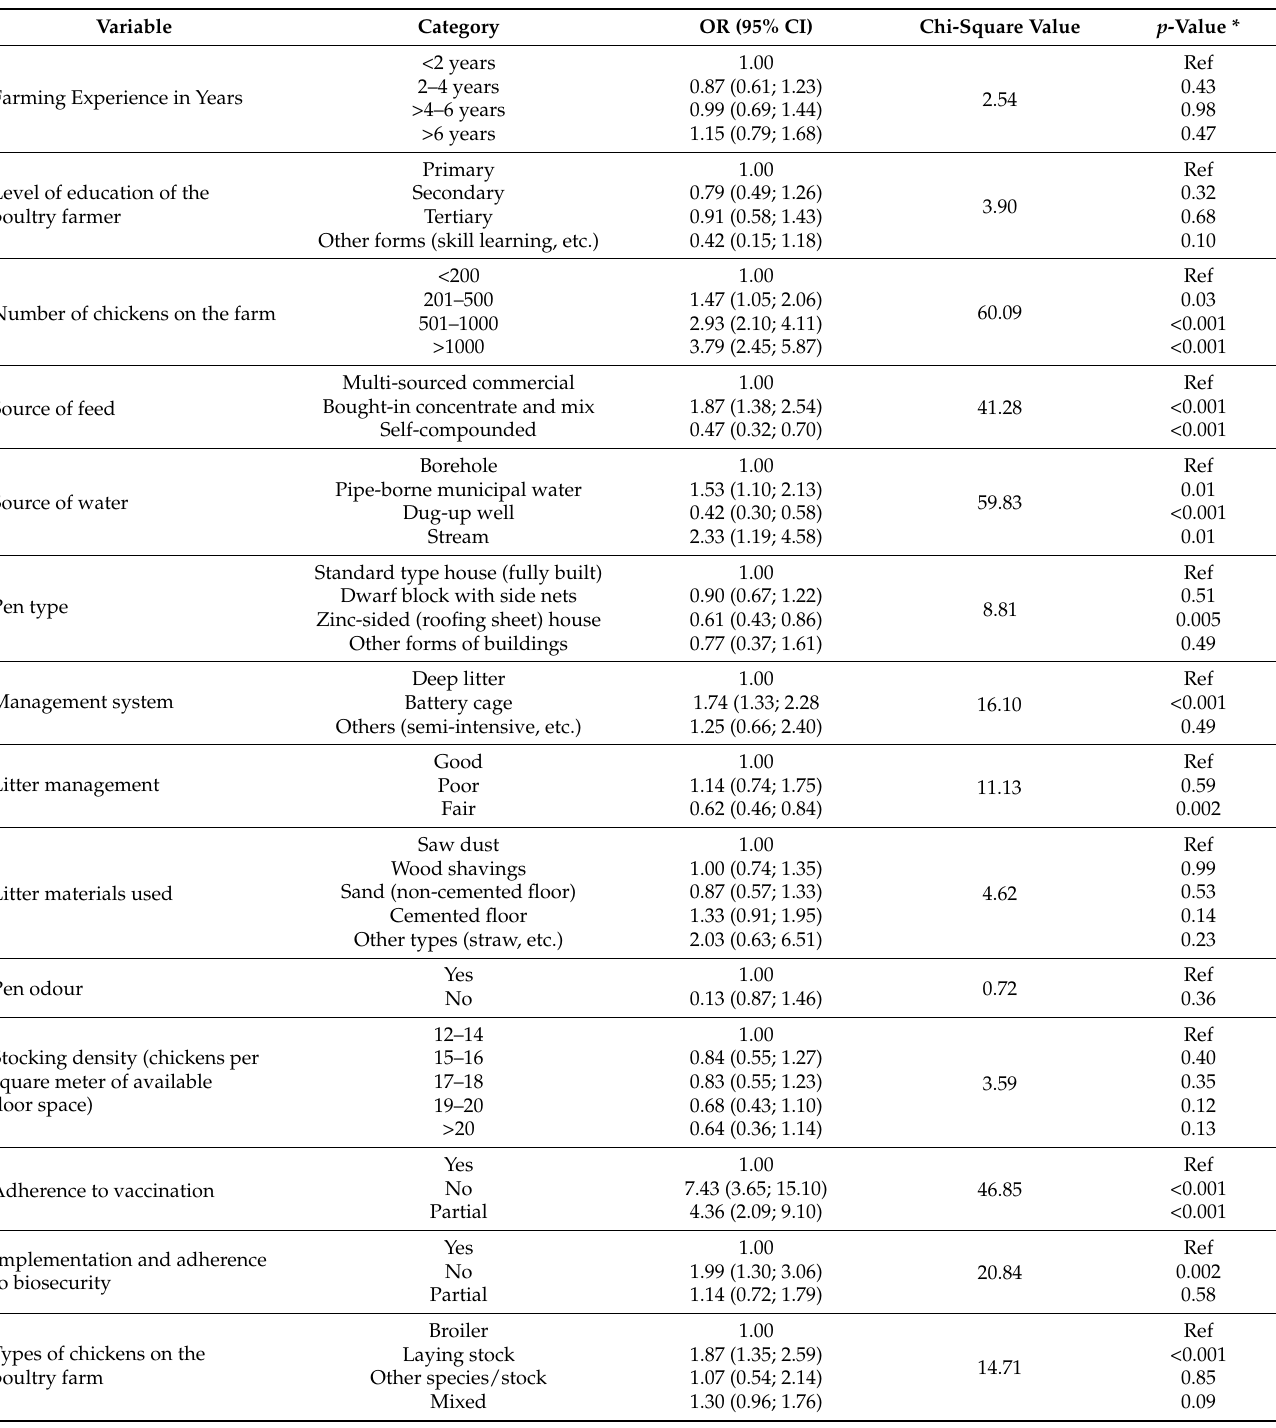
Table 4. Univariable analysis for contamination of poultry farms with Non-Typhoidal Salmonella (NTS) in North Central